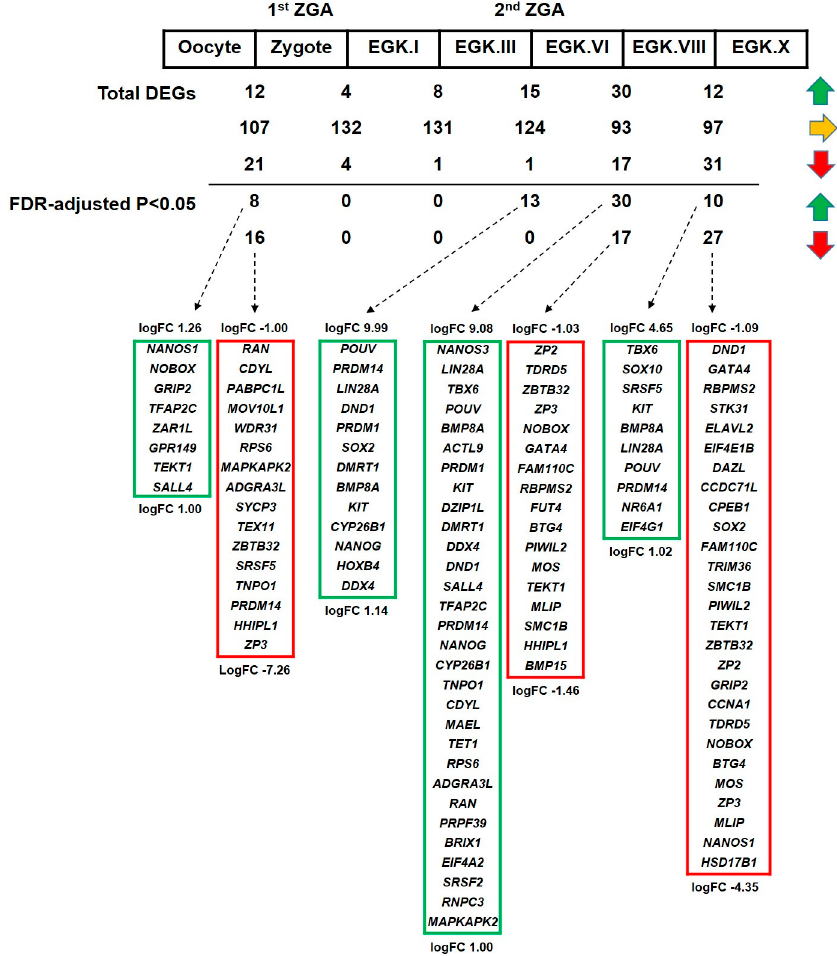
Figure 5. Differentially expressed DAZL interacting genes between consecutive stages of intrauterine embryonic development in chicken. The differentially expressed genes between stages are detected using a negative binomial-based GLM. In total, six statistical tests are performed: oocyte versus zygote, zygote versus EGK.I, EGK.I versus EGK.III, EGK.III versus EGK.VI, EGK.VI versus EGK.VIII, and EGK.VIII versus EGK.X. FDR-adjusted p < 0.05 is considered for significant genes. logFC > 1 is considered for upregulated genes (green arrow), logFC < − 1 is considered for downregulated genes (red arrow), and genes fall between these logFC conditions is considered as unchanged (yellow arrow). The logFCs of genes listed at the top and bottom in a box are mentioned.